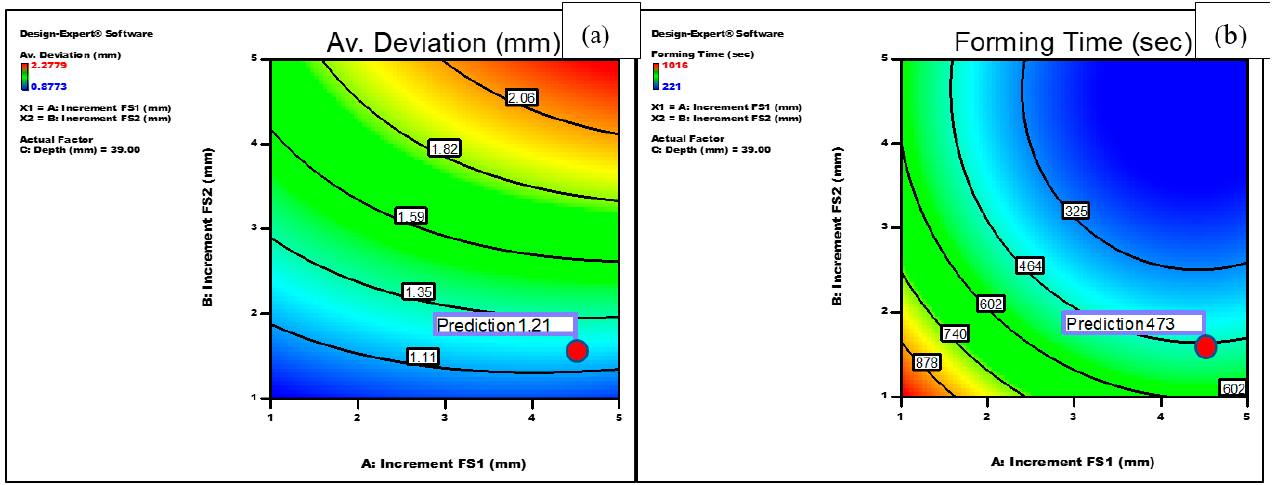
Figure 9. Predicted optimum process parameters for minimising the process responses ( a ) average deviation and ( b ) form- ing time.